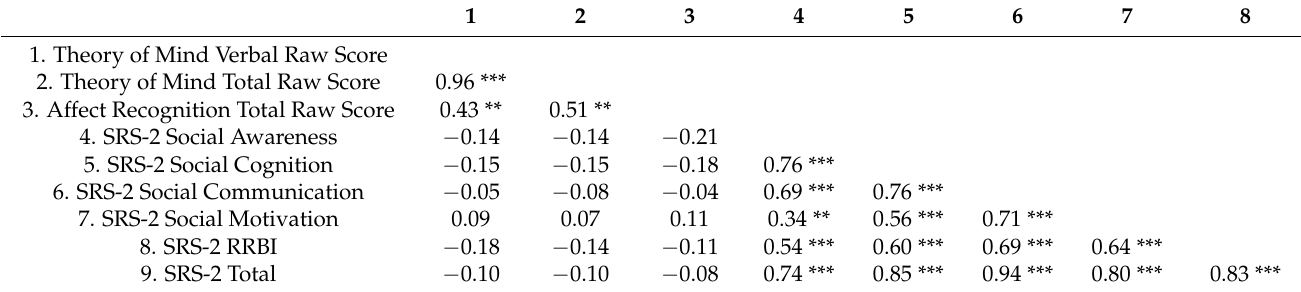
Table 3. Bivariate Pearson correlations to assess convergent validity and associations among social measures at Time